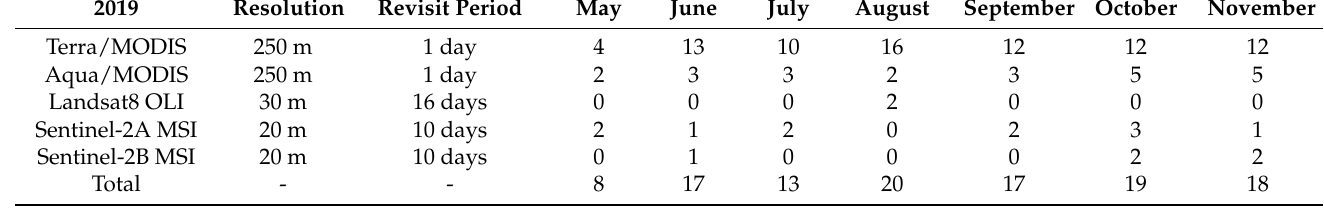
Table 1. Multi-sensor data of the cloudless images of Chaohu Lake in 2019.